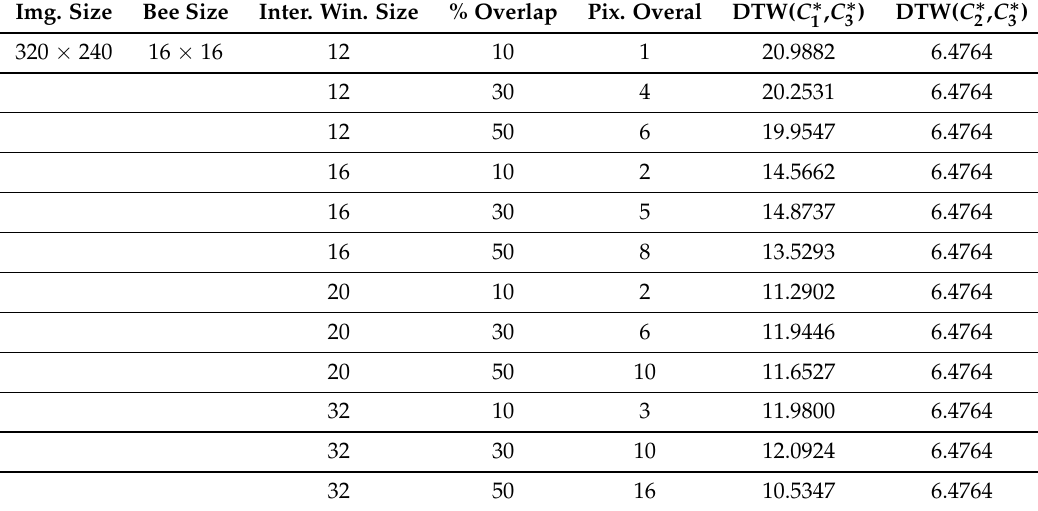
Table A11. DTW values for NT _ Vid . mp 4 with image size of 320 × 240; C ∗ and C ∗ is Human Count (ground truth). 3